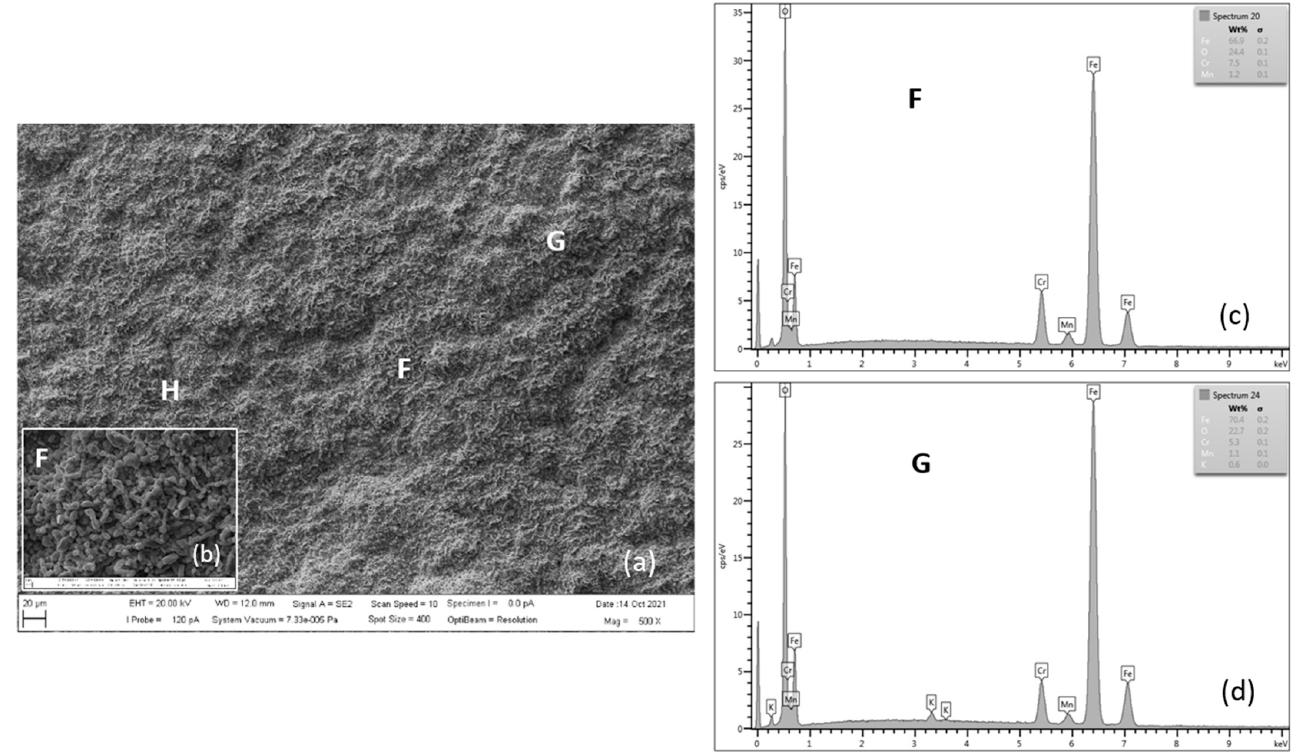
Figure 15. SEM morphology of surface layer of P91 steel oxidized for 3000 h at 650 °C ( a ), with F location detail ( b ), EDX energy spectrum of steel oxide surface ( c , d ).